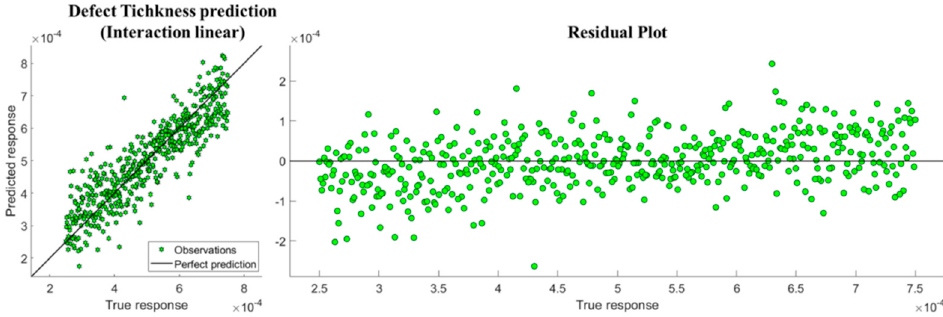
Figure 7. Interaction regression model for all the features ( R 2 = 0.79, MAE = 5.148 × 10 − 5 ).